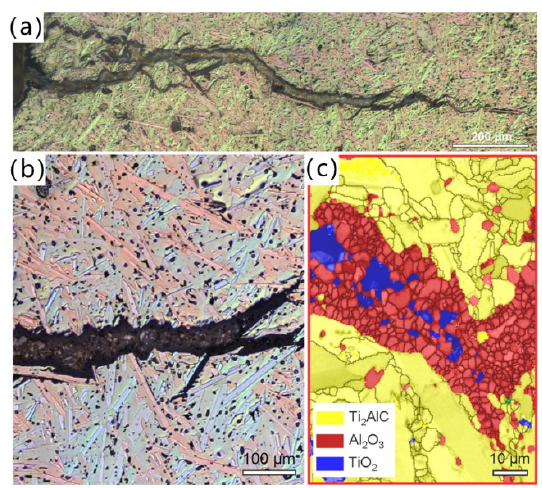
Fig. 6 Healing of the wide damage in Ti 2 AlC at 1200 ℃ for 100 h. (a) A low magnification optical image of the healed crack. (b) A high magnification optical image taken from (a). Two opposite fracture surfaces were covered by the same Al 2 O 3 layer (black) and the gap between two surfaces was fully filled by a mixture of Al 2 O 3 (black) and TiO 2 (large white particles). (c) EBSD image of the healed-damage zone. Reproduced with permission from Ref. [83], © Elsevier Ltd.